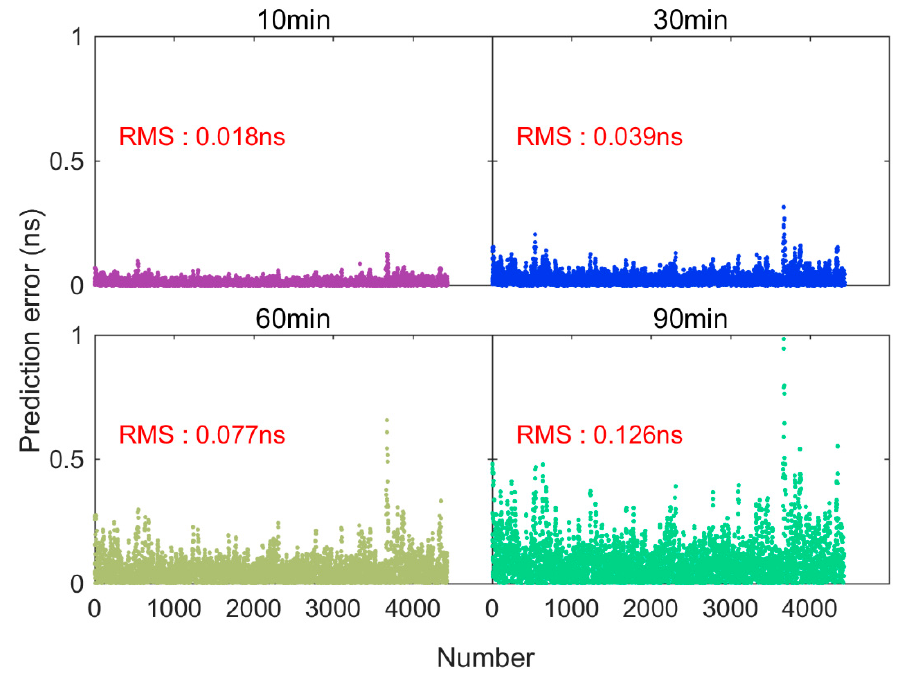
Figure 4. Prediction error of the adaptive clock prediction model at station BRUX at 10, 30, 60 and 90 min.